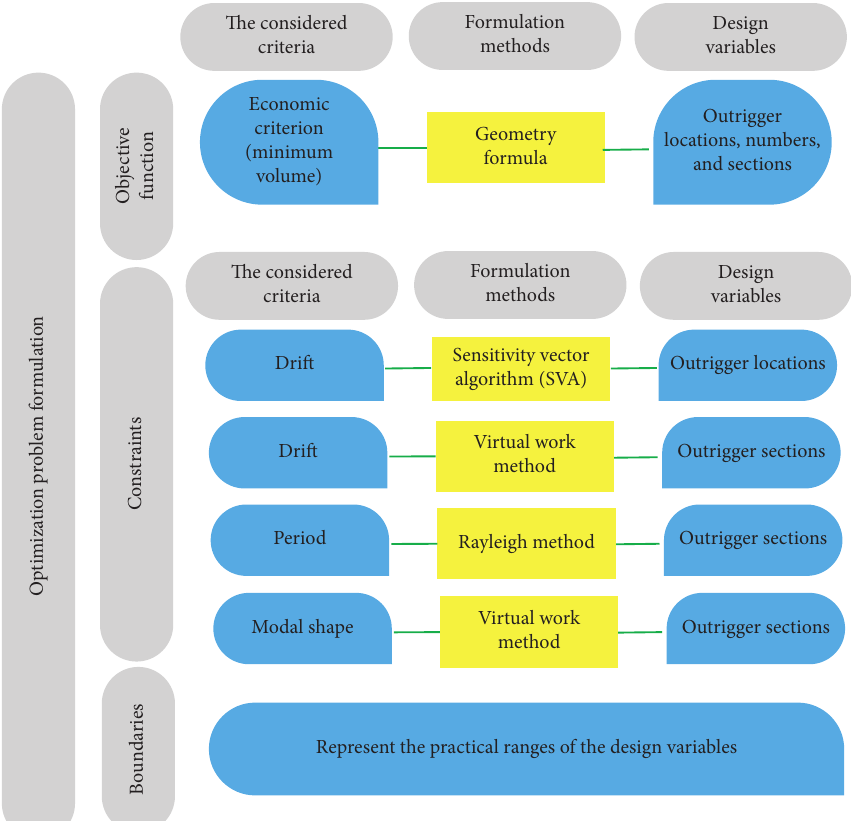
Figure 10: Problem formulation example as presented in references